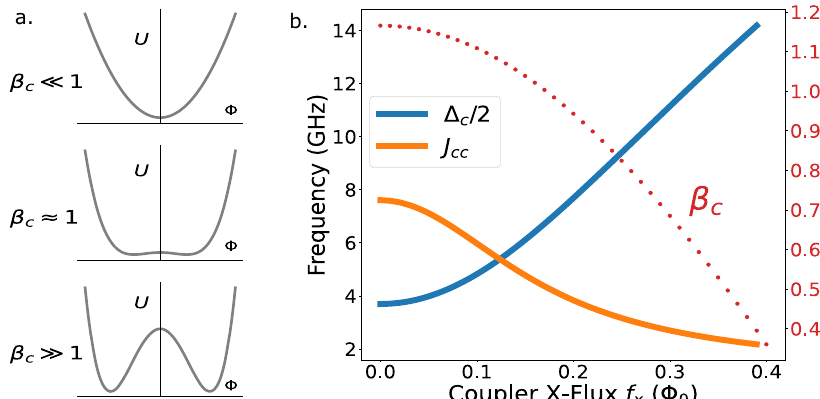
Fig. 2 Single Coupler Behavior. a The ratio of the Josephson inductance to the geometrical inductance, β c , dictates the shape of the potential energy of the tunable rf-SQUID coupler circuit. When the geometrical inductance dominates, β c ≪ 1, the potential energy landscape is approximately harmonic. When the Josephson inductance dominates, β c ≫ 1, the energy landscape becomes double-welled with each minimum representing oppositely circulating current states. Due to the large energy barrier between the states, moderate changes in f z do not change the current state of the circuit. The coupling is optimized when the geometrical and Josephson inductances are approximately equal. This results in a wide, shallow energy minimum where even slight changes in f z can induce strong fl uctuations between the oppositely circulating current states of the coupler circuit. b Both the single coupler transverse fi eld, Δ c /2, and the intercoupler interaction energy, ¼ M z I z J c , are displayed as a function of the coupler f x when f z = Φ 0 /2. These parameters are calculated in single coupler simulations c i c i þ 1 I c i c i þ 1 i c i þ 1 and then transcribed into spin model parameters. The equality of these two terms appearing in the transverse fi eld Ising model for f x ≃ 0.14 Φ 0 signals the location of the quantum critical point, in the vicinity of which we expect long-range correlations to emerge. In addition, the dependence of β c is displayed as a function of the coupler's f x for f z = Φ 0 /2. By design, the optimum coupling point, β c ≈ 1, coincides with the coupler f x value where we expect critical behavior in the coupler